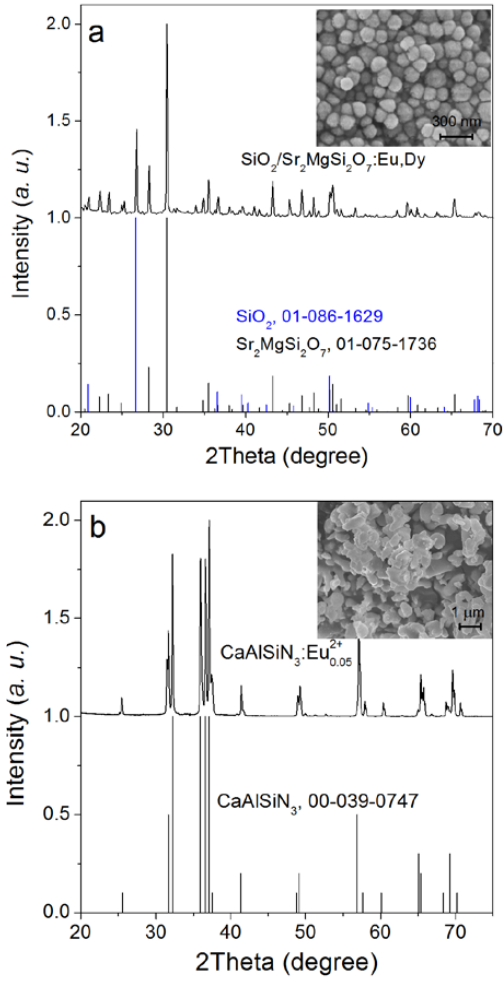
Figure 1. X-ray diffraction patterns and scanning electron microscopy images of the